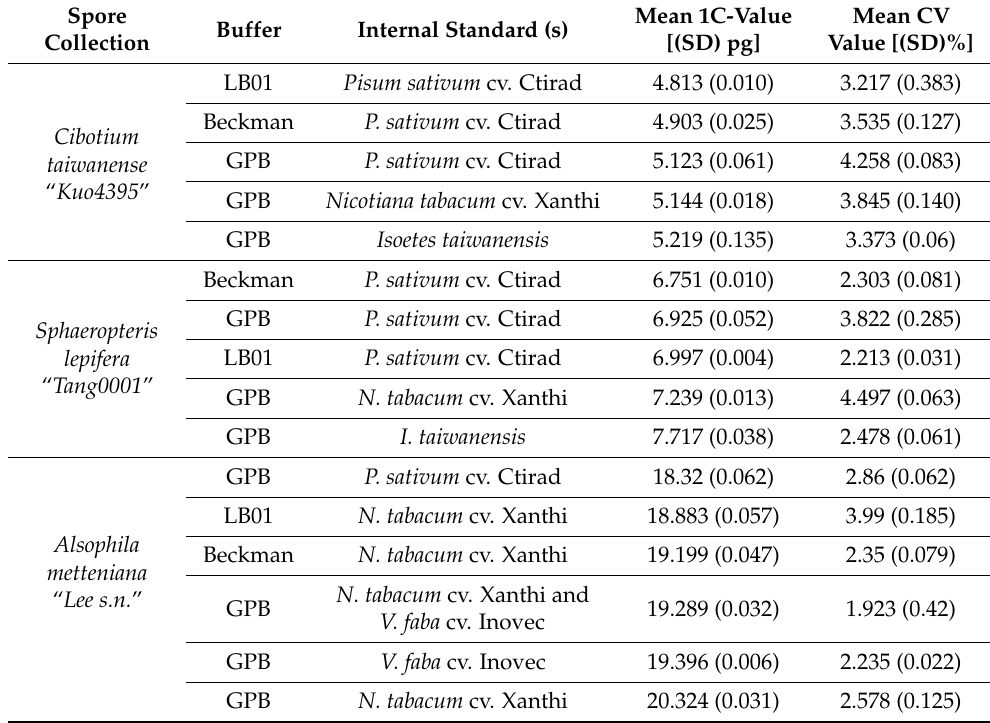
Table 3. C-value estimates of the three spore collections using different buffers and internal standards and inferred by interpolation.